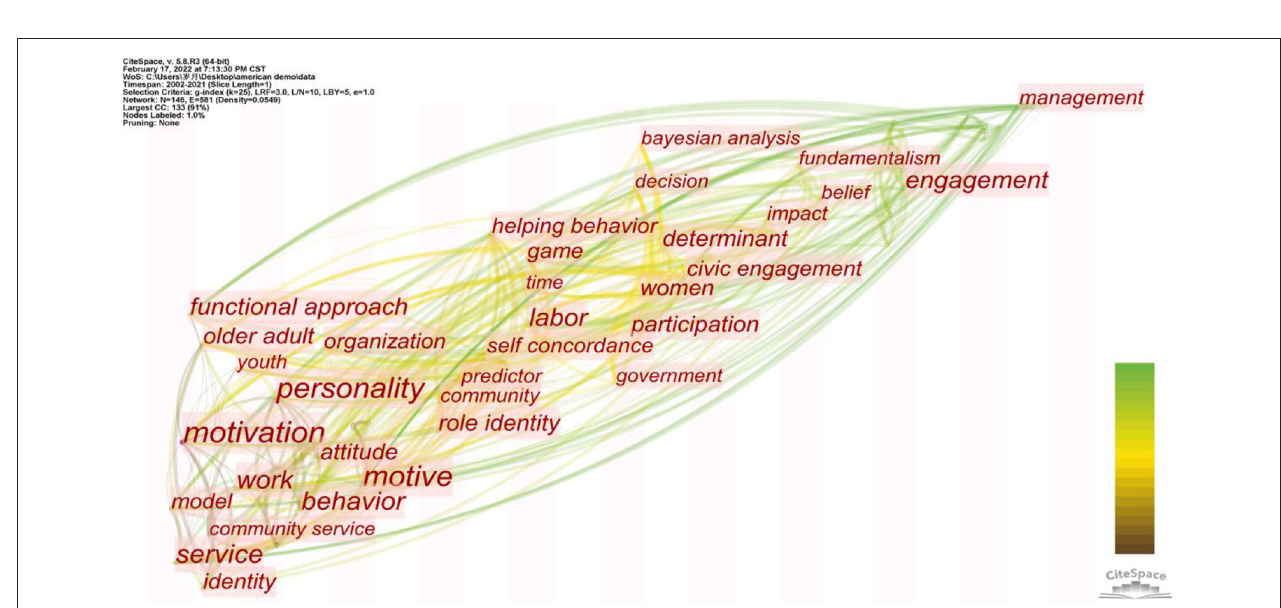
FIGURE 7 | Map of timezone view in Chinese volunteer motivation research.